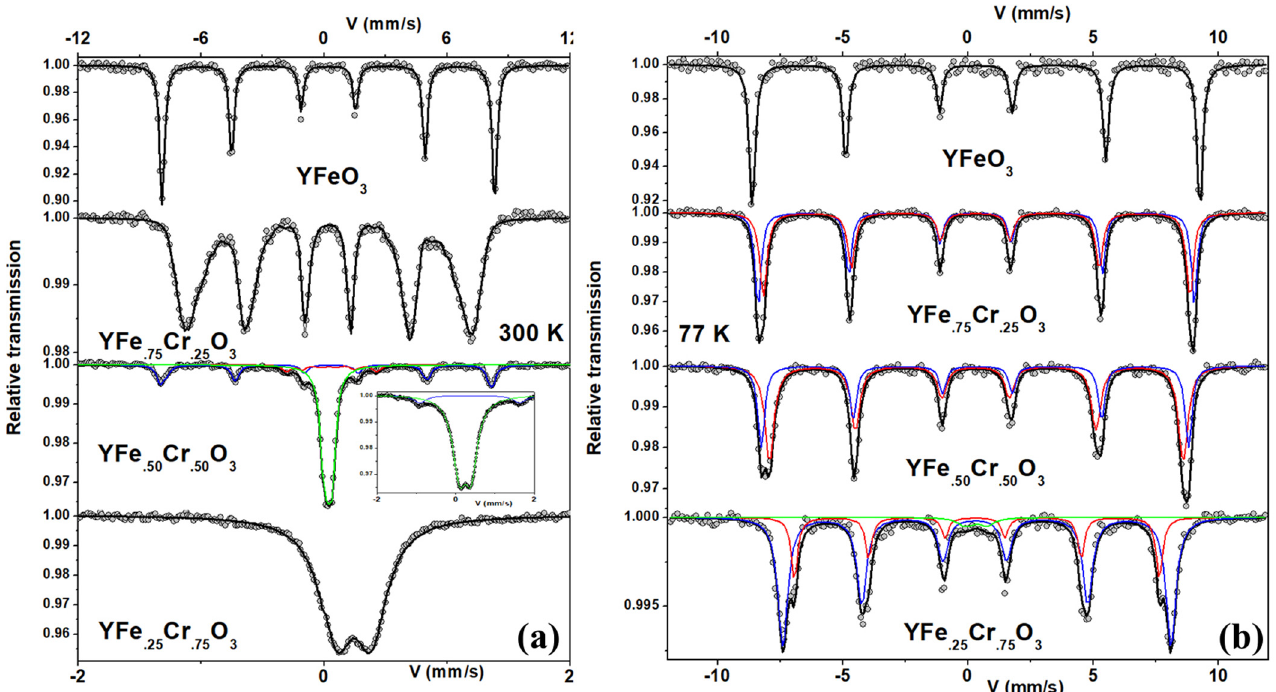
Figure 12. ( a ) RT Mössbauer measurements of the Fe-substituted YFe x Cr 1 − x O 3 compounds. Samples with x = 1.0, 0.75, and 0.5 are measured with ± 12 mm/s. The inset shows the same spectra for x = 0.5 but with a maximal velocity of ±2 mm/s, as in the case of the YFe 0.25 Cr 0.75 O 3 sample (last spectrum). ( b ) Same sample measured at 77 K. The subspectra used to fit these spectra are also shown. The two sextets represent the two iron configurations in octahedral sites of the orthorhombic crystal structure of the perovskite. Table 3. Refined values of the hyperfine parameters at given temperatures.